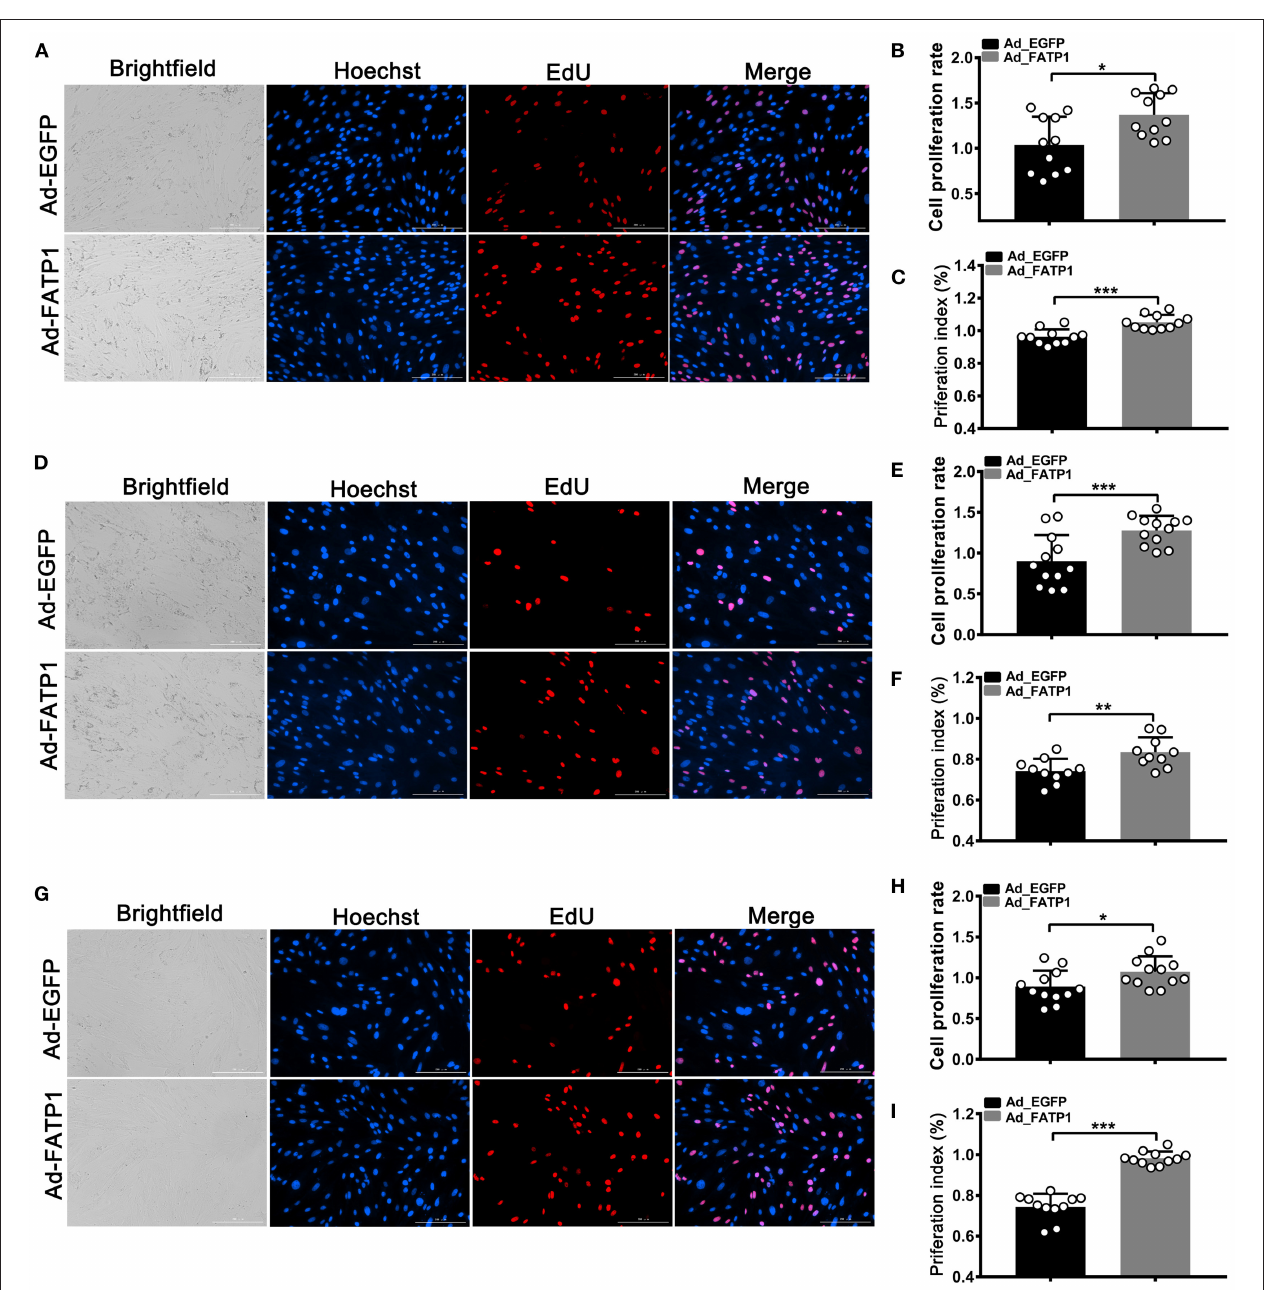
FIGURE 5 | FATP1 promotes the proliferation of buffalo myocytes, intramuscular preadipocytes, and subcutaneous preadipocytes. (A,D,G) Micrographs of EdU assays for buffalo myocytes, intramuscular preadipocytes, and subcutaneous preadipocytes, respectively. Blue indicates the nuclei of all the cells; EdU-stained nuclei are shown in red. Scale bar, 200 µ m. (B,E,H) Statistical analysis of EdU assays for buffalo myocytes, intramuscular preadipocytes, and subcutaneous preadipocytes, respectively. (C,F,I) Statistical analysis of CCK-8 assays for buffalo myocytes, intramuscular preadipocytes, and subcutaneous preadipocytes, respectively. Data are presented as means ± SD; * p < 0.05, ** p < 0.01, *** p <